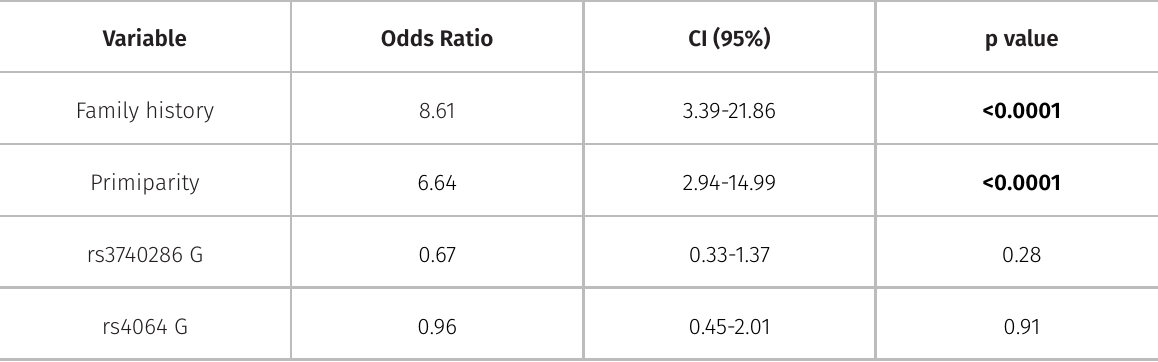
Table III. Assessment of risk factors for PE development by multiple logistic regression